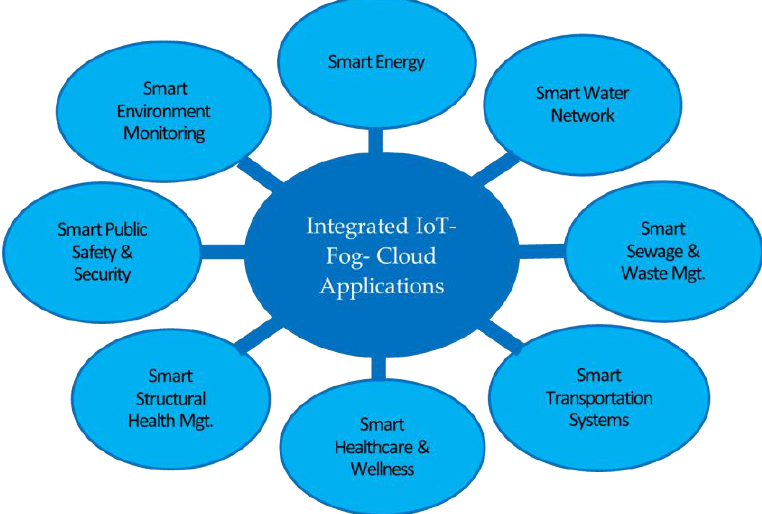
Figure 5. iIFC smart city application domains.